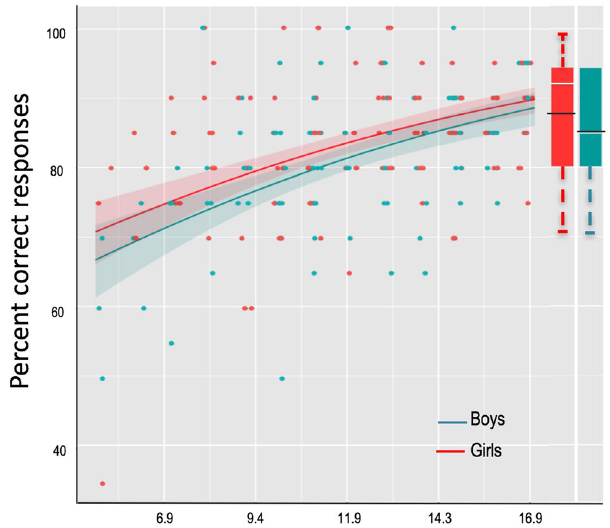
Figure 1. Proportion of correct responses as a function of age for boys and girls. Each dot represents the performance of one participant. The graph is centered on the mean age of the developmental sample (11.8 years) The lines represent the predicted performances as a function of age for males and females separately for the model: Response ~age + age 2 + 1|Subject (from the function sjp.glmer; Lüdecke D (2017). sjPlot: Data Visualization for Statistics in Social Science . R package version 2.4.0, https://CRAN.R-project.org/ package = sjPlot). Shaded areas represent confidence intervals. Boxplots represent median and 75 percentile in adults’ data; the black lines represent the mean performance of